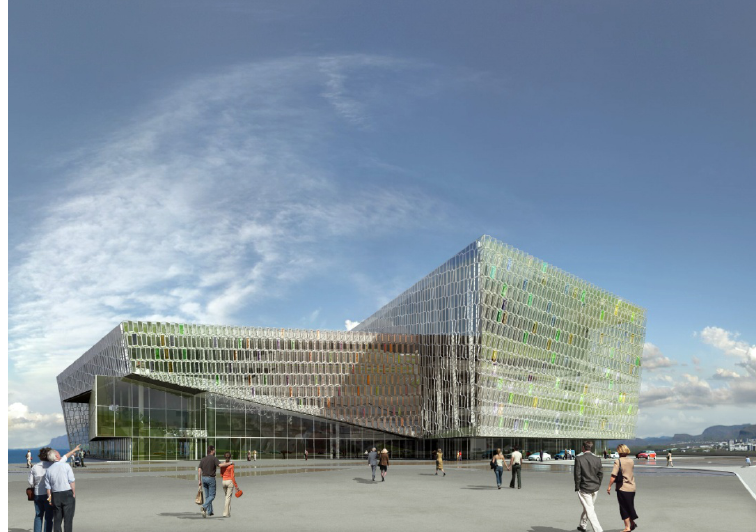
Figure 1: Rendering of south elevation, Reykjavik New Concert Hall, HLA.